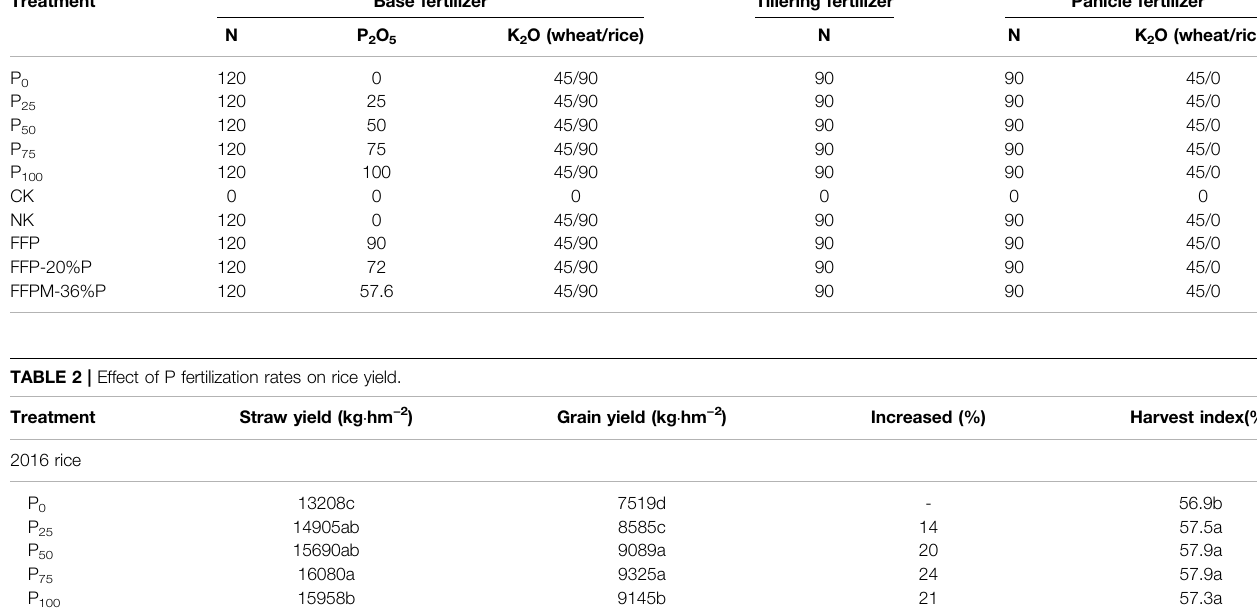
TABLE 1 | Fertilizers for wheat and rice cultivation (kg · hm − 2 ). Treatment